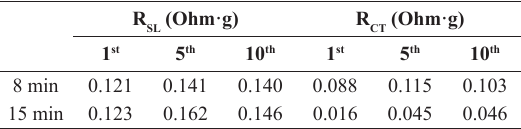
Figure 5. (a) Nyquist plots for lithium cells assembled with samples treated for 8 and 15 minutes and measured after 1 st , 5 th and 10 th discharge. (b) Equivalent circuits used for the fitting of the spectra. Table 2. Surface layer and charge transfer resistance values calculated from impedance spectra of lithium cells assembled with samples treated for 8 and 15 minutes. Cells were measured after one, five and ten